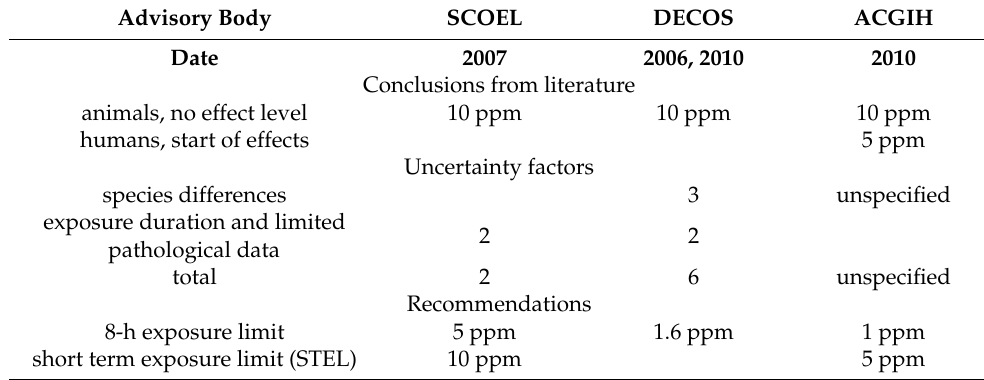
Table 2. Recommendations for occupational exposure limits for hydrogen